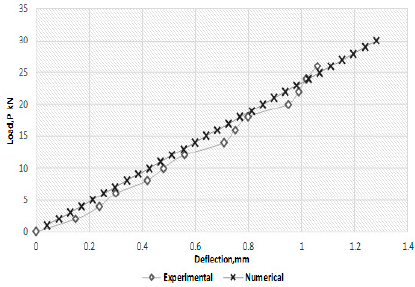
Figure 29. Load–deflection diagram of beam (B7).